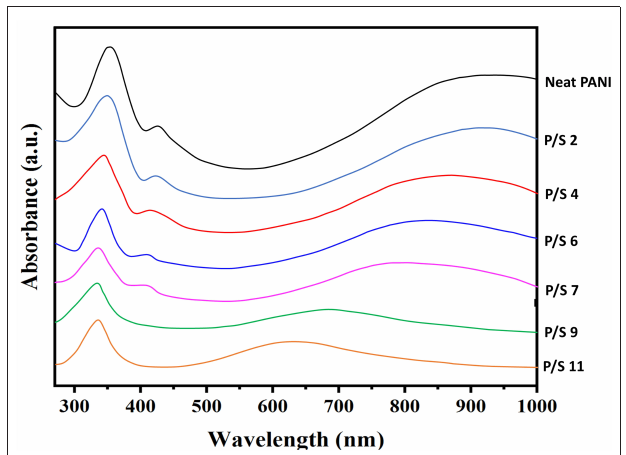
FIGURE 4 | UV-Vis spectrums of PANI, Sago and PANI/Sago blends of varying pH.